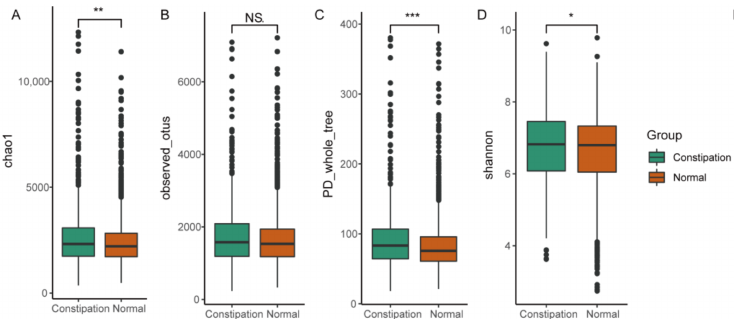
Figure 2. All gut microbiome diversity indices, except the observed operational taxonomic units, increased in patients with constipation ( A – D ). Statistical significance between groups is indicated by NS, *, **, ***, corresponding to p > 0.05, <0.05, <0.01 and <0.001